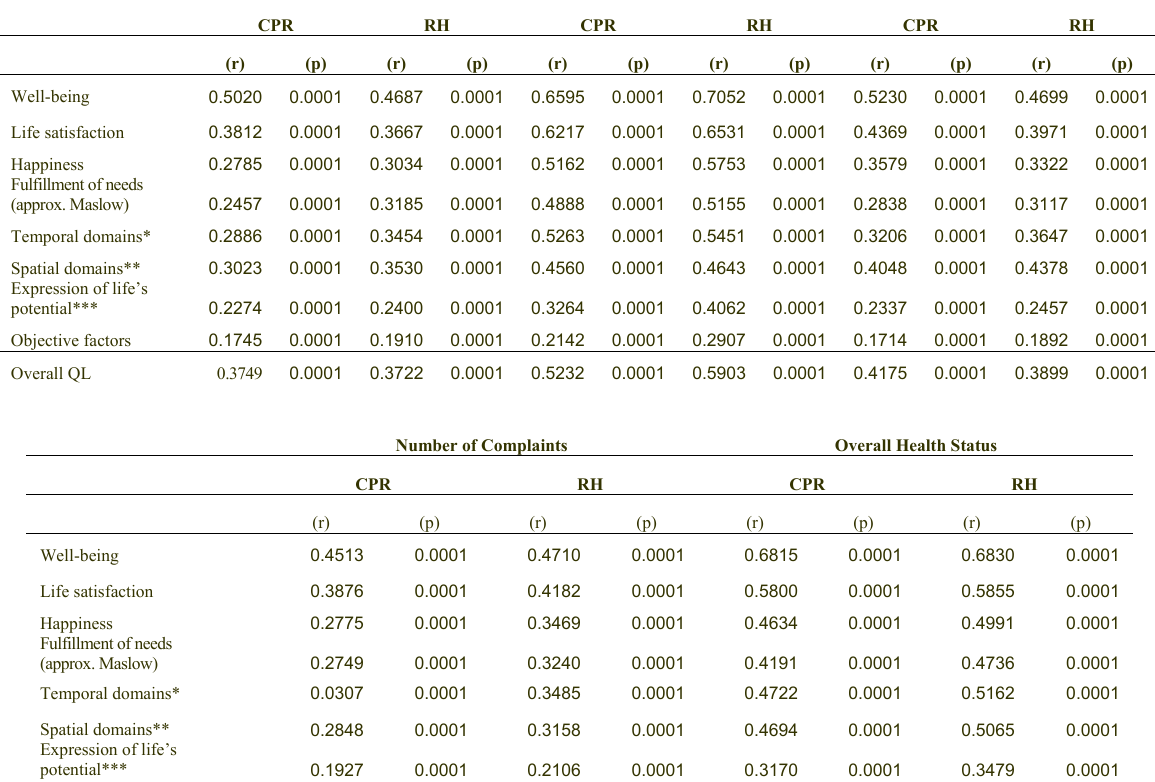
Pearson Correlation (r,p) between Health and Quality of